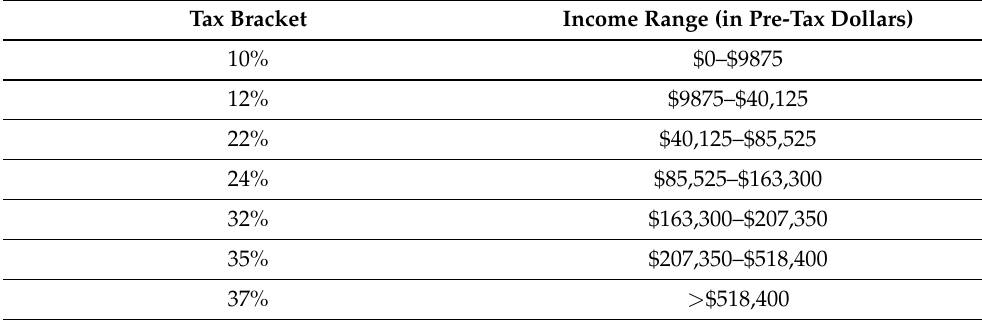
Table 5. 2020 tax brackets for a single investor. The income range for these brackets is adjusted by our inflation rate of 3% in later years, reflecting current tax